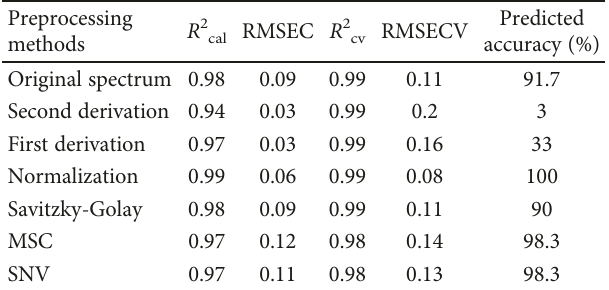
Figure 4: Using the Mahalanobis distance, spectral outliers of beef (a), pork (b), and mutton (c) were identi fi ed. Table 1: Classi fi cation of model parameters before and after exclusion of outliers.